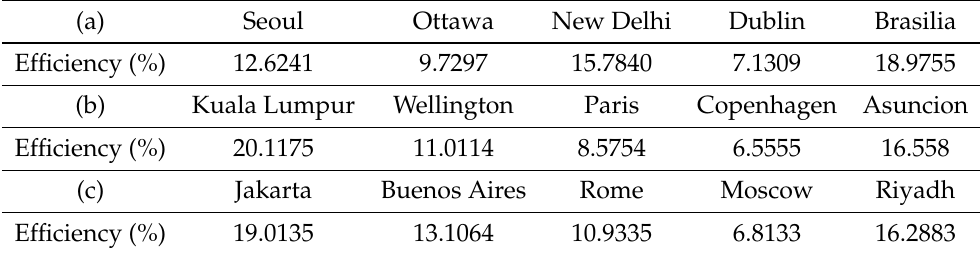
Table 4. The annual energy efficiency based on (13) for each city. The azimuth angle is (a) 73 π /72, (b) 35 π /36, (c) 17 π